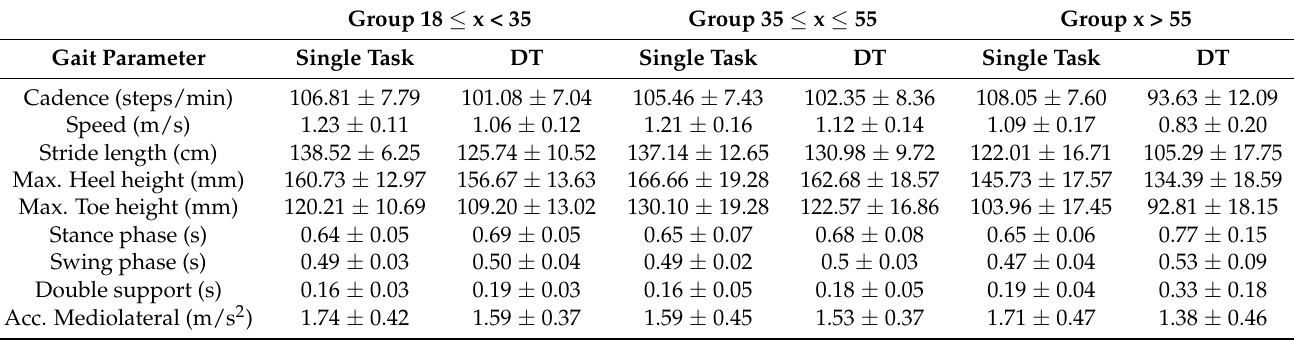
Table 3. Spatiotemporal parameters obtained by volunteers separated into age groups for single task (only gait) and dual tasks. Values are mean ± standard deviations.